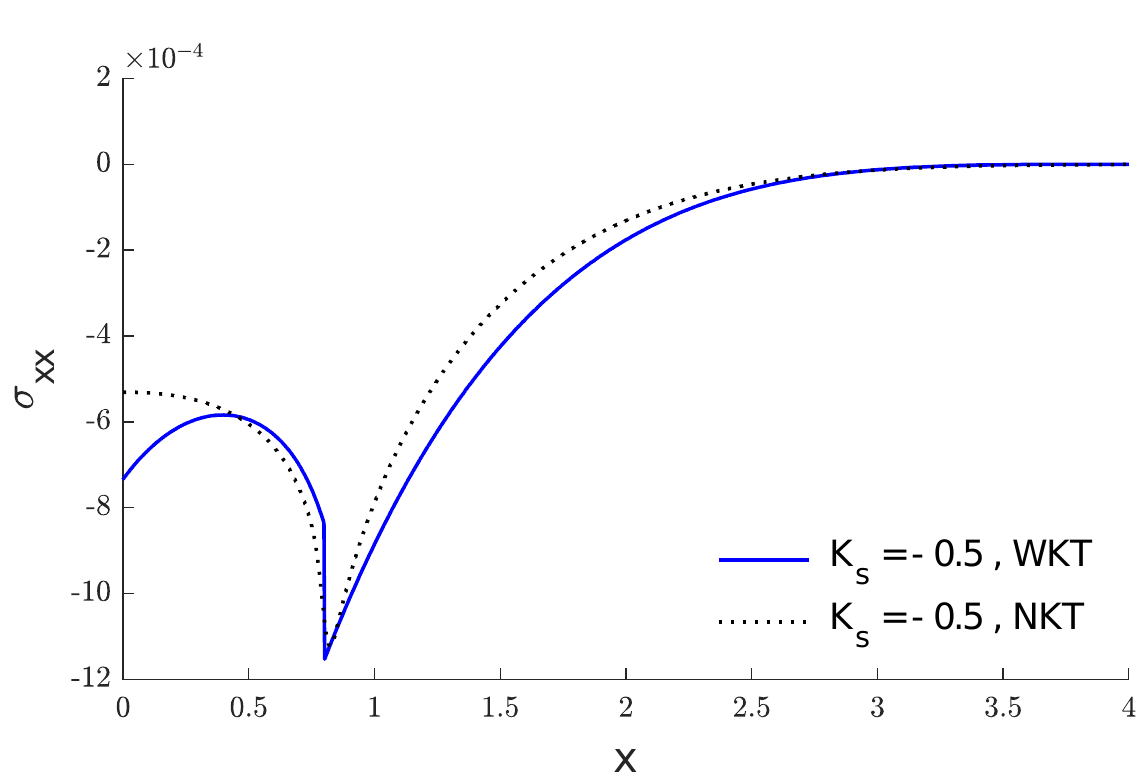
Figure 12. The stress variations with and without Kirchhoff transforms when 𝐾 𝑠 = −0.5 .